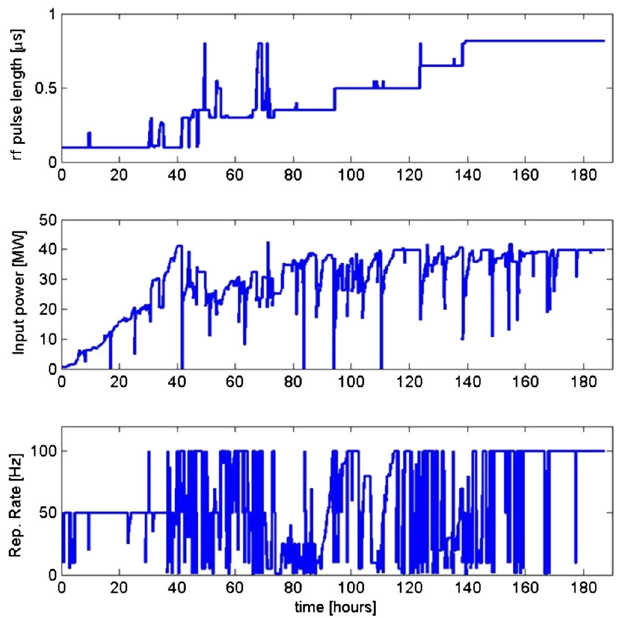
FIG. 16. Input, transmitted, and reflected power signals in the case of 30 MW input power and 0 . 35 μ s pulse length. The signals are not to scale, since we used different attenuations for the diodes.